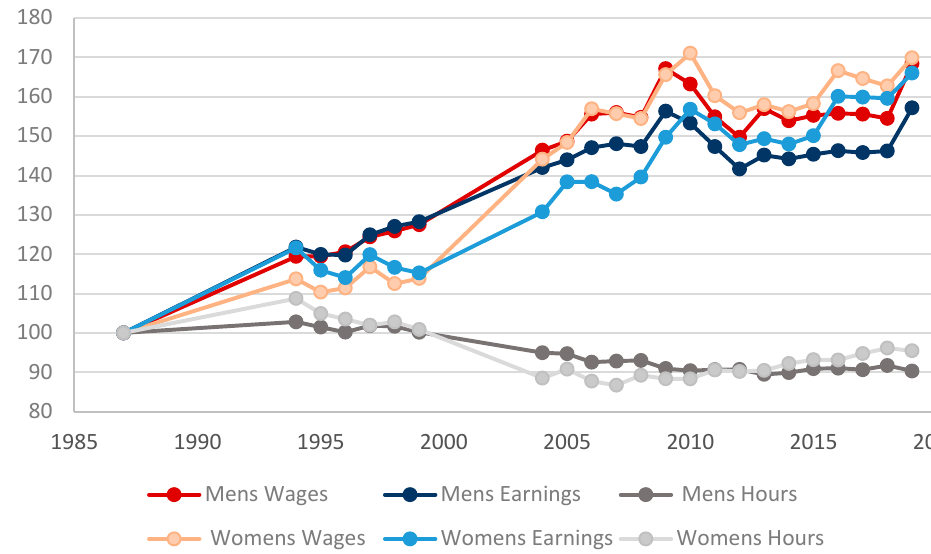
Figure 2. The evolution of real hourly wages, hours or work, and real earnings of men and women.